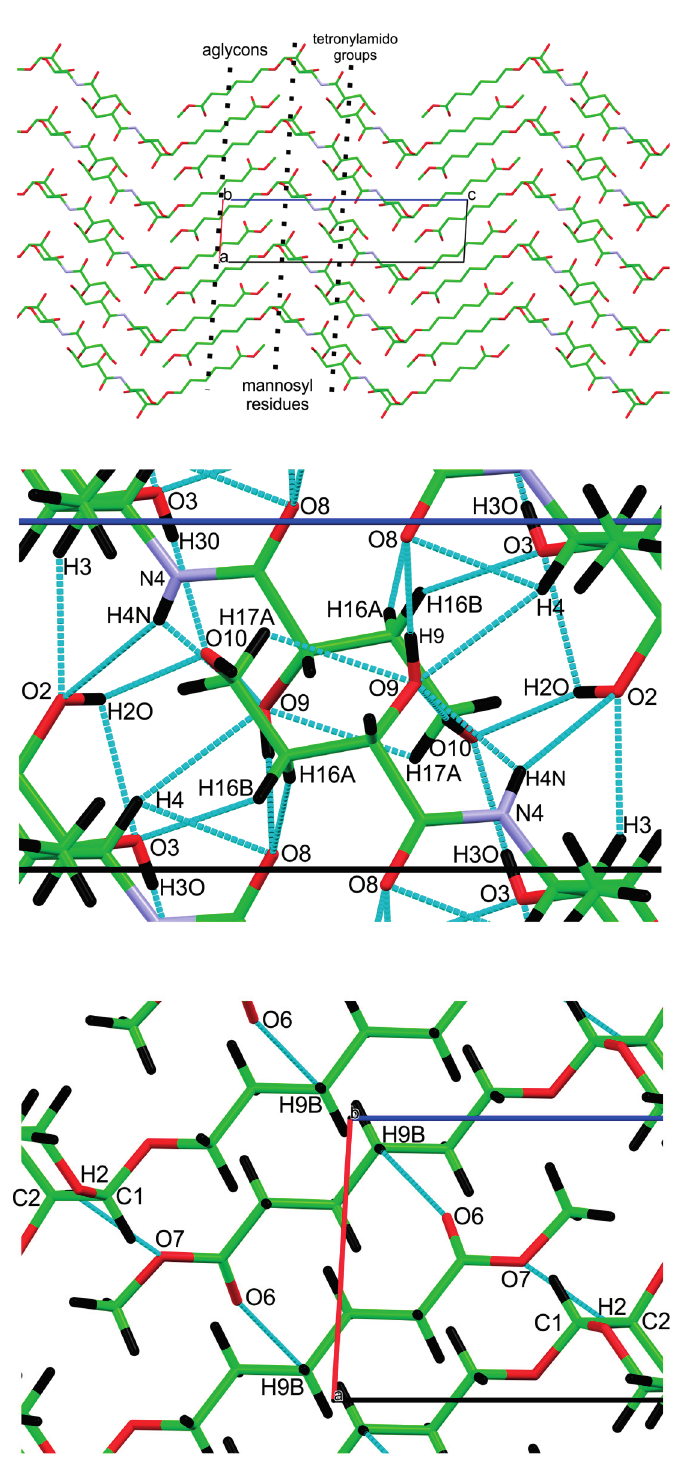
Figure 3. Crystal packing and hydrogen bonding, viewed along the b -axis of the unit cell. The upper drawing has the aglycon units along the a -axis, and the tetronylamido groups are located at the center of the unit cell. The mannosyl units are at about ¼ (and ¾) of the c -axis. The middle and lower figures show the details of the hydrogen bonding near the center and corner of the cell, respectively. The H2 atoms are hidden behind the C1-C2